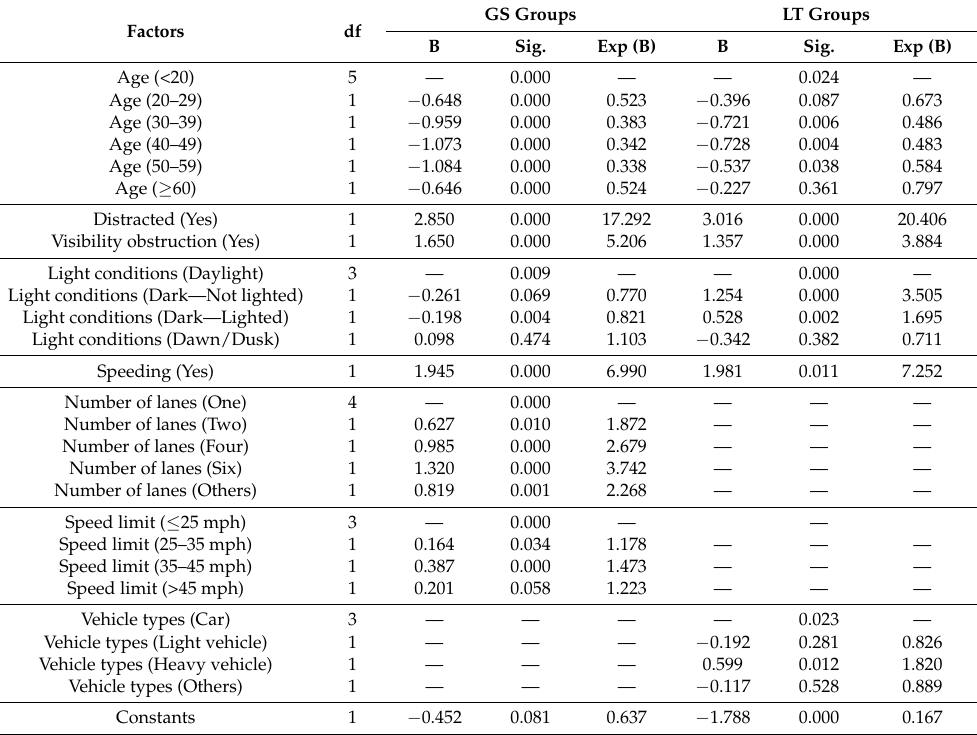
Table 3. Logistic regression results of RLR crashes for GS group and LT